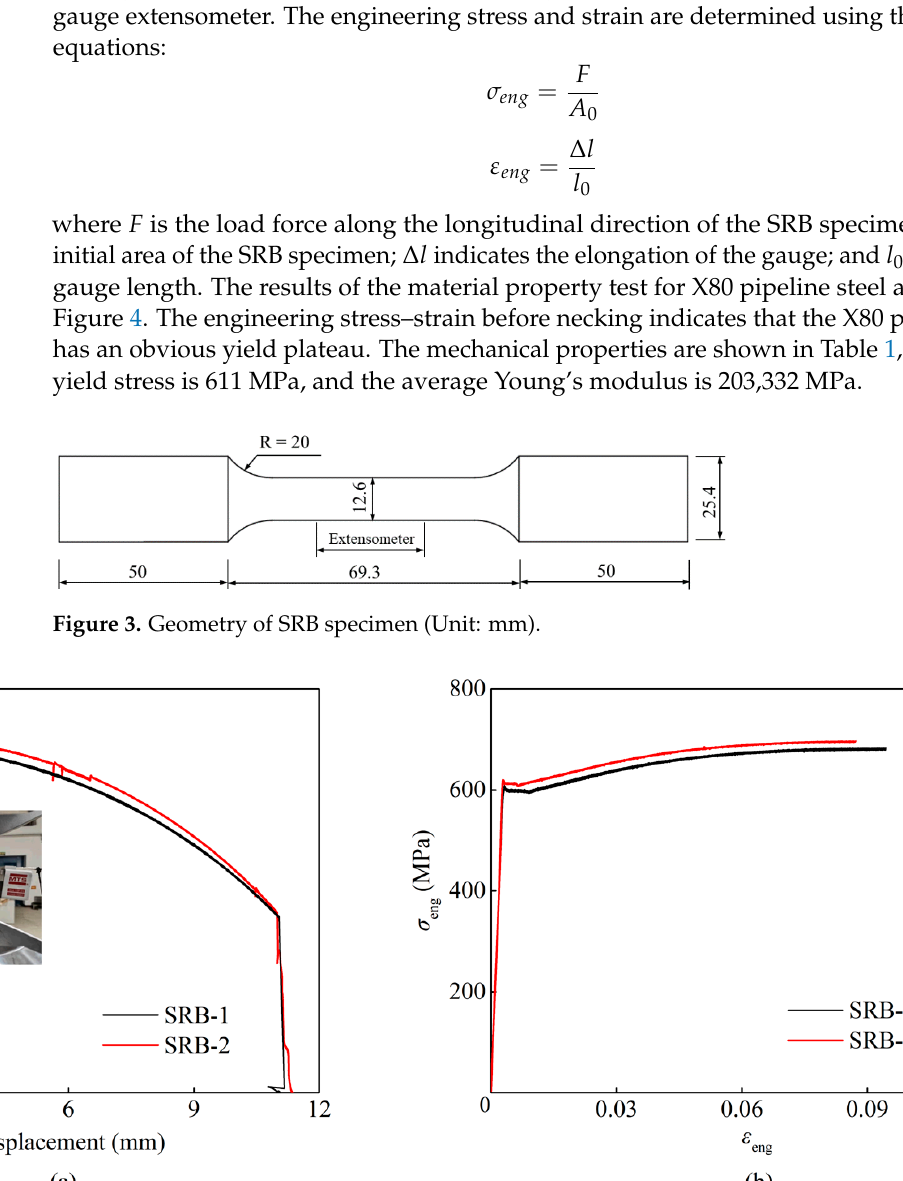
Figure 2. Flowchart of the calibration procedure for the VGM.